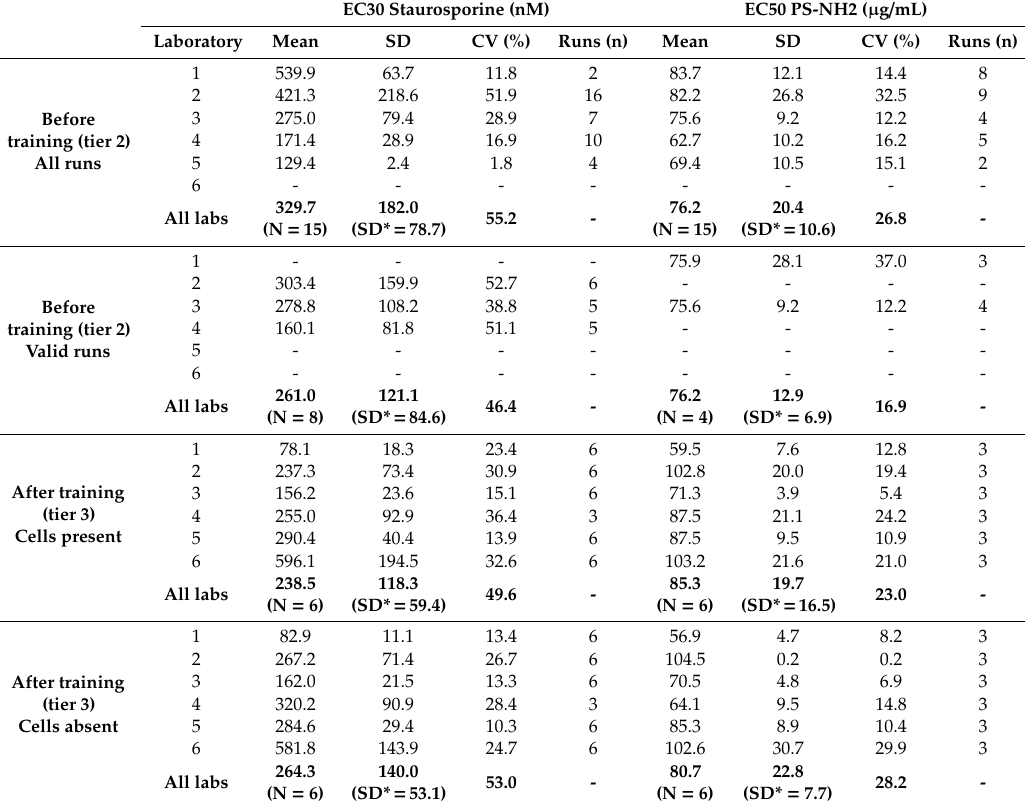
Table 3. Comparison of intra- and inter-laboratory biases for EC30 and EC50 values before (tier 2) and after (tier 3) training in quality aspects of MTS assay performance. Individual data from the six laboratories that were trained, as well as the overall data of all laboratories (N; in bold and between brackets) are included. Mean and SD (and SD*, in bold and between brackets) values of calculated EC30 (nM staurosporine) and EC50 ( µ g / mL PS-NH2), coe ffi cient of variation (CV) (%) and number of runs (n) are given. For tier 2, data from all (valid and non-valid) runs and valid runs only are indicated. Tier 3 data are presented in the presence and absence of cells. ‘-’ indicates that no data were available, laboratory 6 participated only in tier